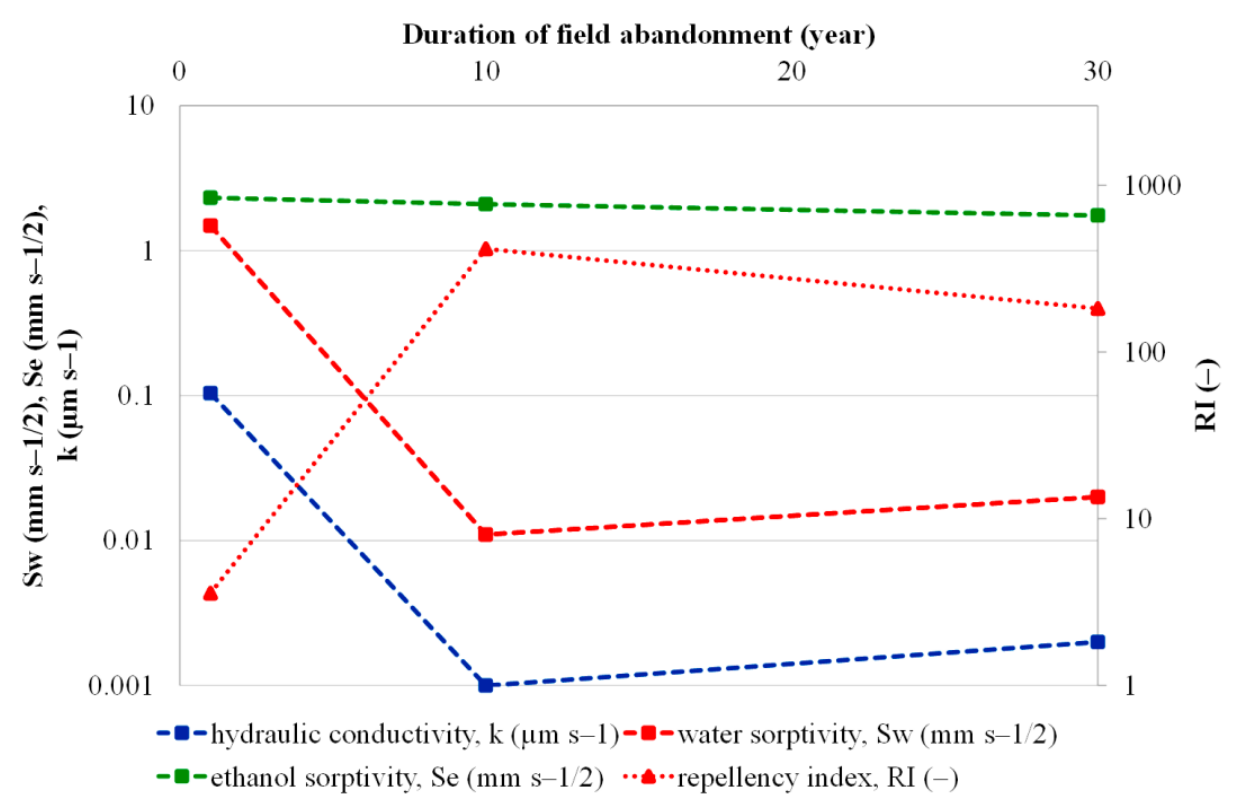
Figure 2. Relationships between hydraulic conductivity, k ( − 2 cm), water sorptivity, S w ( − 2 cm), ethanol sorptivity, S e ( − 2 cm), and repellency index, RI, estimated in the top layer of acidic sandy soils, and duration of field abandonment at experimental sites S1, S2, and S3 located at Studienka village in the Borská nížina lowland (southwestern Slovakia). Note that both vertical axes have a logarithmic scale.